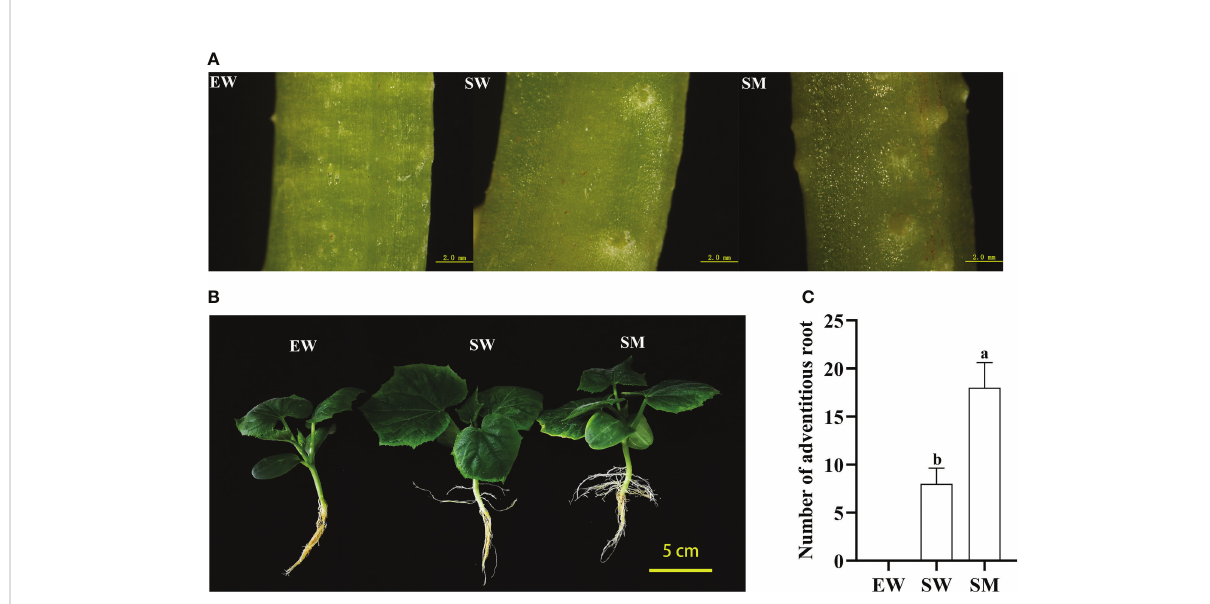
FIGURE 1 Effects of melatonin on adventitious root (AR) development of cucumber seedings under hypocotyl shading conditions. (A) Observation of AR primordium development with stereoscope after 3 days under EW, SW, and SM treatment (scale bar = 2 mm). (B) Observation of AR morphological after 12 days under EW, SW, and SM treatment (scale bar = 5 cm). (C) Number of AR after 12 days under EW, SW, and SM treatment. EW (hypocotyl exposed and irrigated with water); SW (hypocotyl shaded and irrigated with water); and SM (hypocotyl shaded and